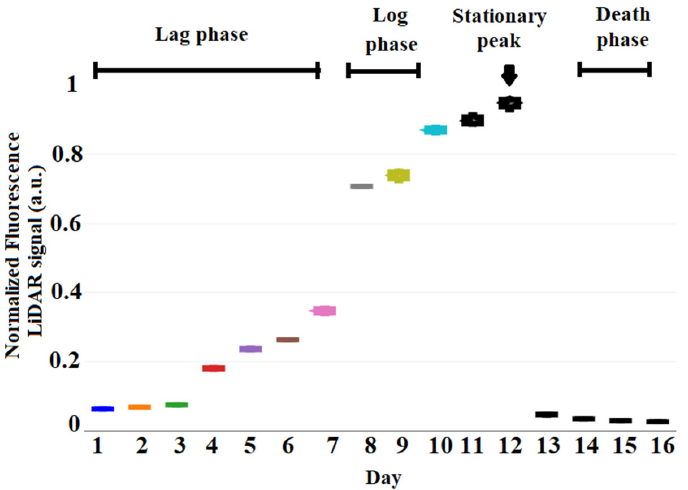
Figure 2. Normalized fluorescence LiDAR signal of C. reinhardtii during the 16-day sampling period. It shows a whisker and box plot showing the different growth phases of C. reinhardtii .